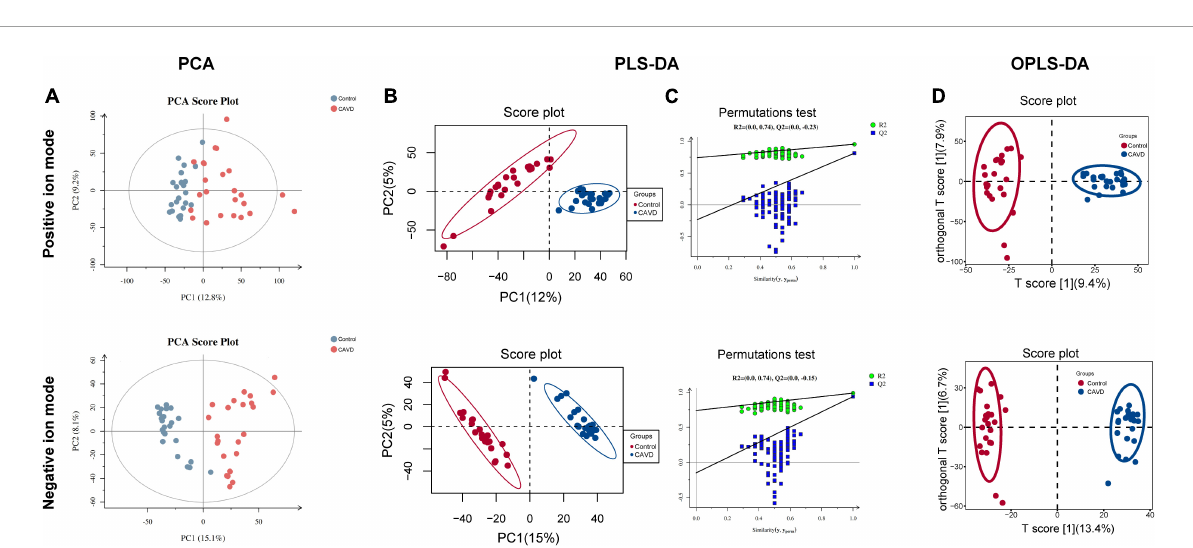
FIGURE2 Metabolic profile changes in heart valve with calcific aortic valve disease. Principal component analysis (A) and PLS-DA (B) score plots; permutation test of PLS-DA model (C) . OPLS-DA score of positive and negative ion metabolites plots (D) . OPLS-DA, orthogonal projections to latent structures discriminant analysis; PCA, principal component analysis; PLS-DA, partial least squares discriminant